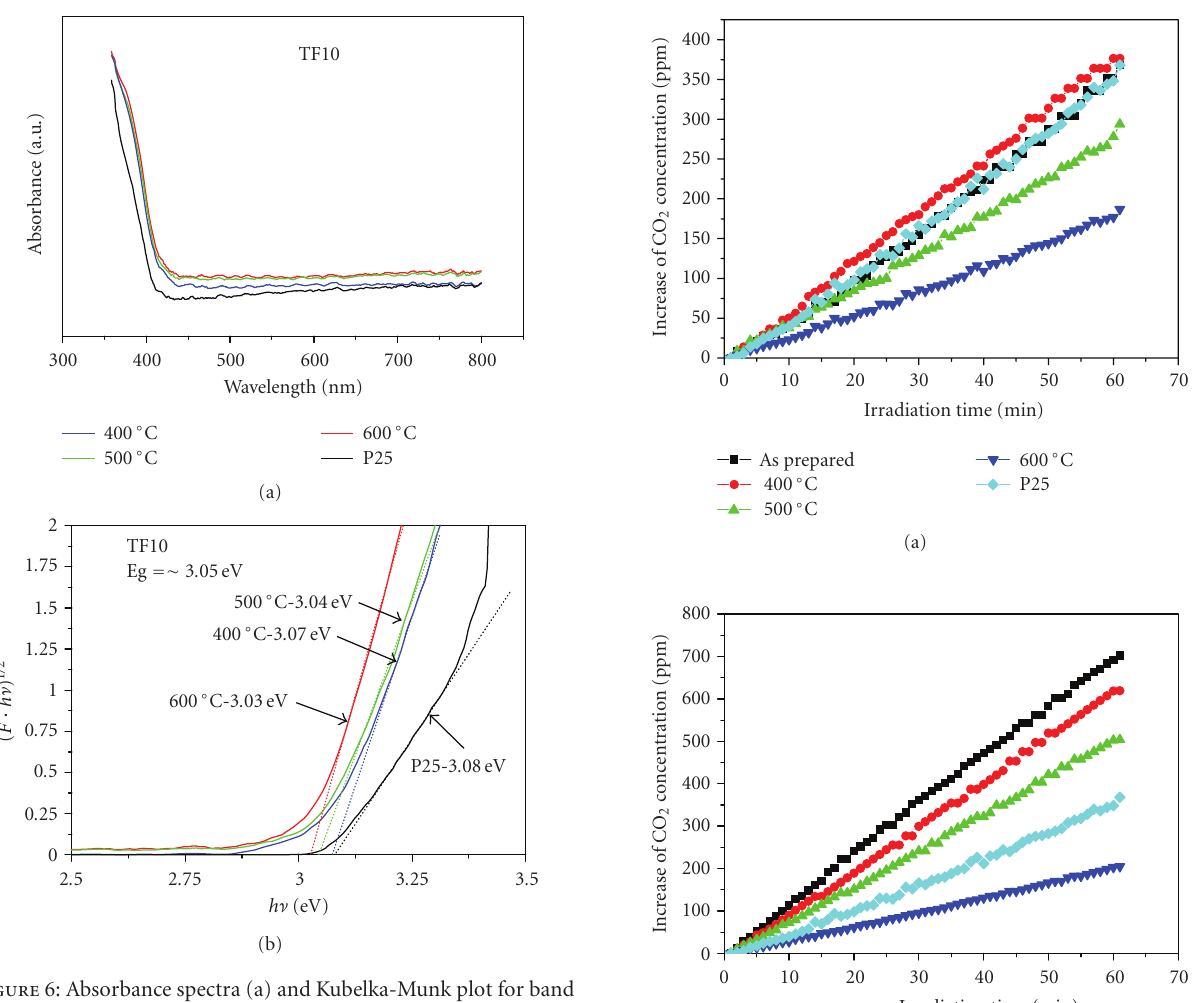
The crystallization of pure rutile or anatase/rutile mix-